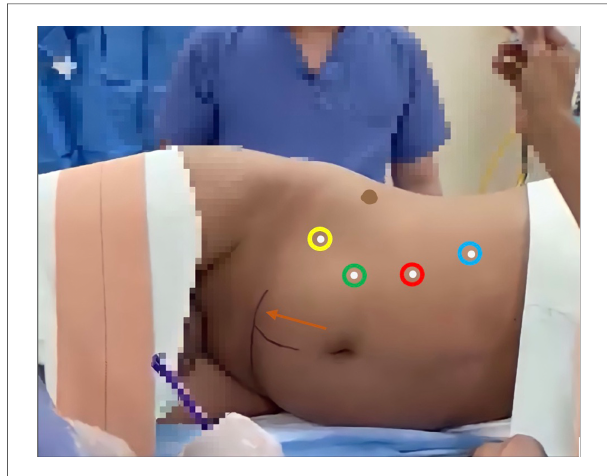
FIGURE 2 Robotic port marking. Green circle: 12 mm Camera port; Blue, red and yellow circles: operating ports, including retractors; Orange arrow: Pfannenstiel incision, and Alexis Port insertion point (Perpendicular line from the umbilicus is for surgeon ’ s guidance